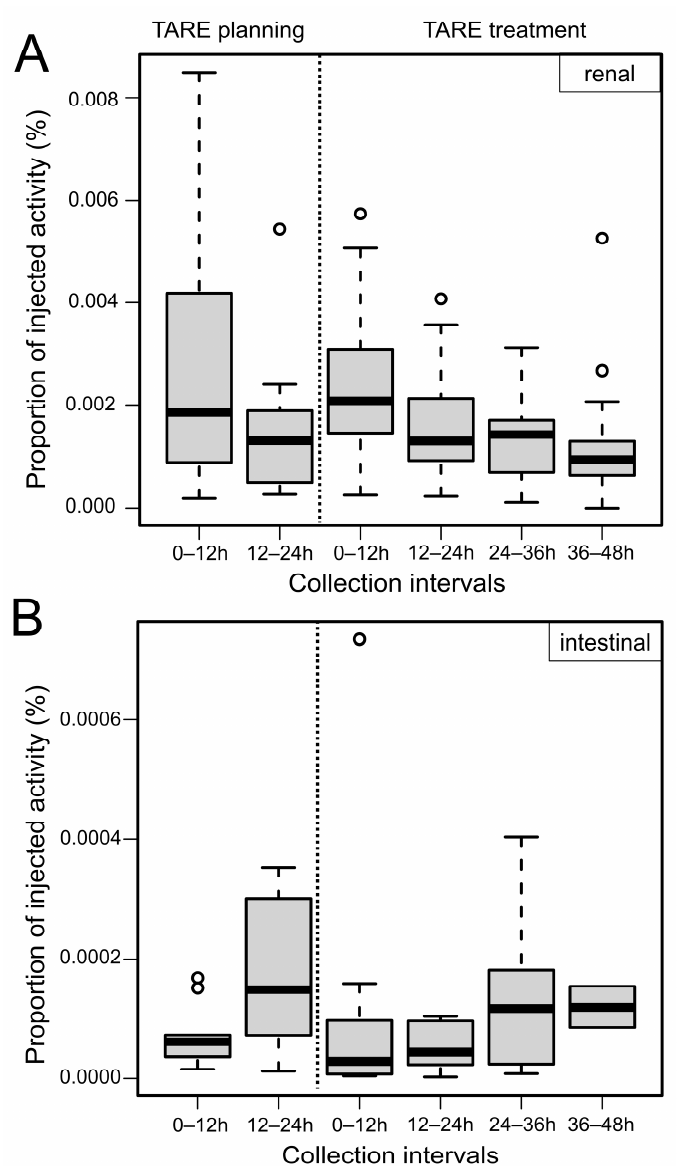
Figure 5. Relativerenal( A )andintestinal( B ) 166 Figure 5. Relative renal (A) and intestinal (B) 166 Ho excretion after TARE planning and treatment procedures.